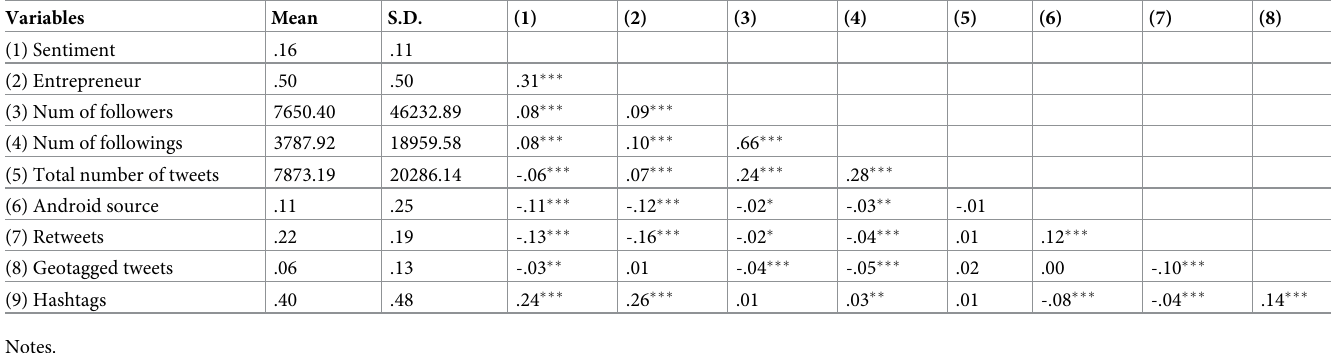
Table 3. Descriptive statistics and correlations for the Los Angeles data (N =